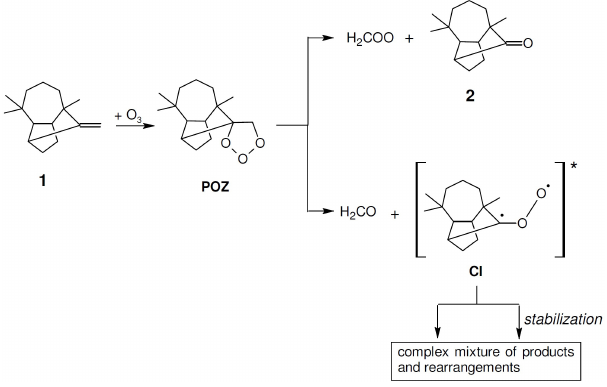
Fig. 1. Theoretical initial ozonolysis reaction pathway for longifo- lene (1) based on work on β -pinene by Nguyen et al.